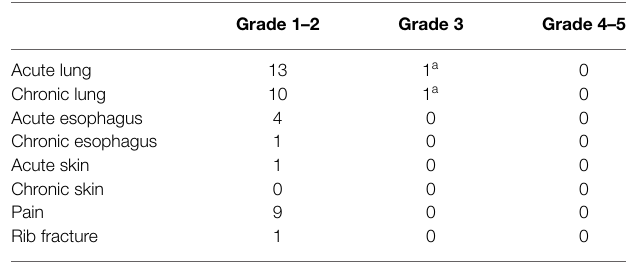
TABLE 3 | Univariate Analysis .